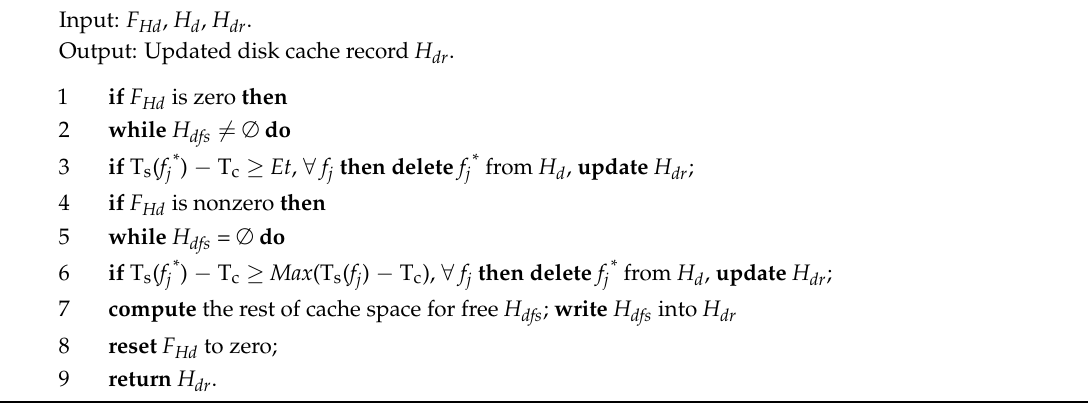
Algorithm 3. Delete out-of-date file in the disk cache